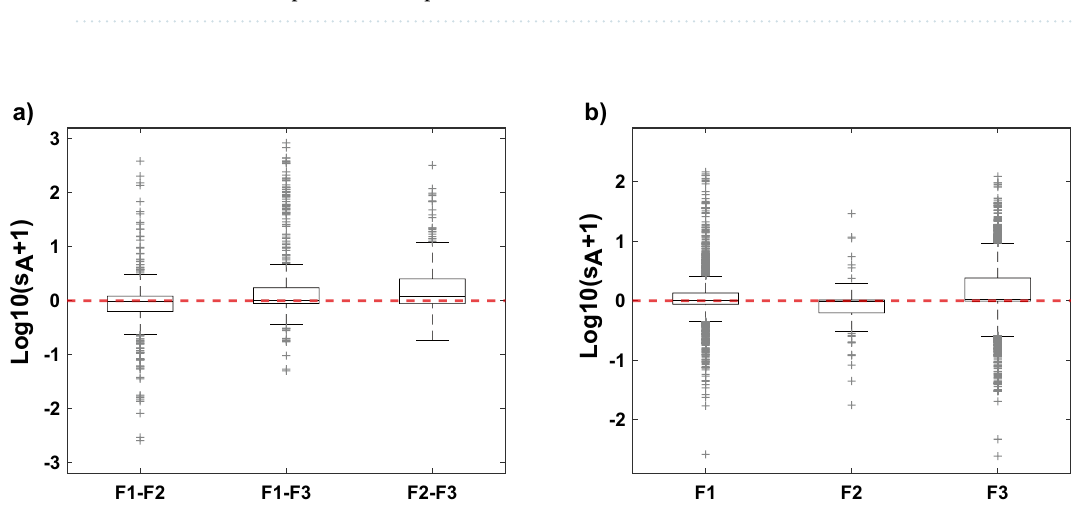
Figure 2. Difference between the mean log10(s A + 1) of different surveys in the selected pixels of 100 m, ( a ) between surveys, and ( b ) within a given survey. s A in m 2 nm −2 ; F1, F2, F3: FAROFA 1, 2 and 3,